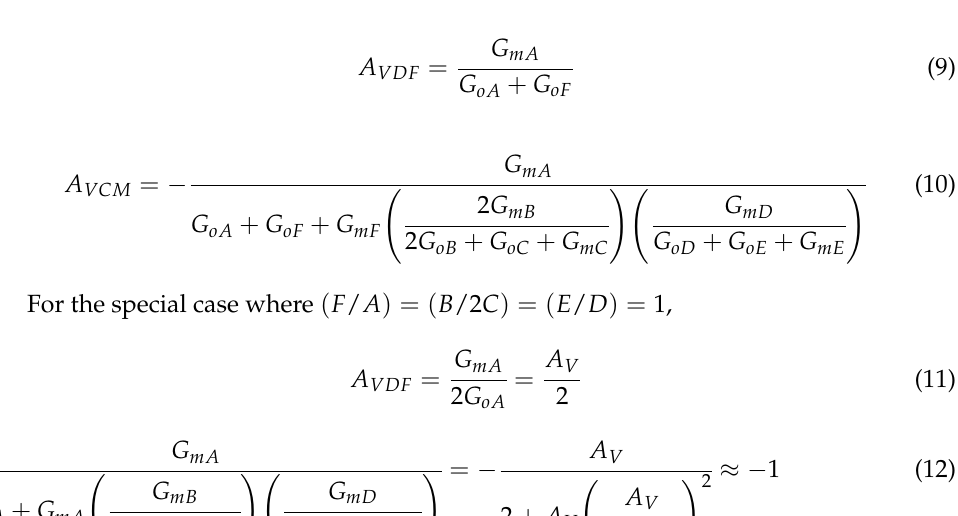
Figure 8. Mafredini (M) OTA circuit diagram